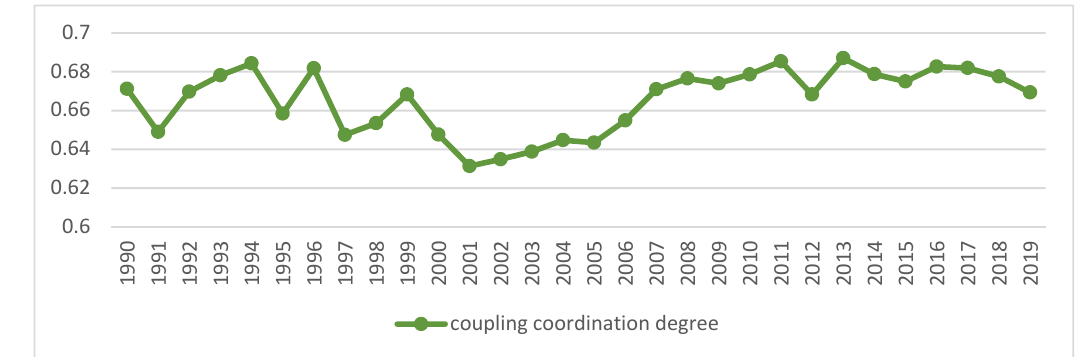
Figure 3. Trends of coupling coordination of China’s industrialization and agricultural green development. Data Source: the authors calculated based on China Statistical Yearbook, China Industrial Statistical Yearbook, China Rural Statistical Yearbook, China Regional Economic Statistical Yearbook.